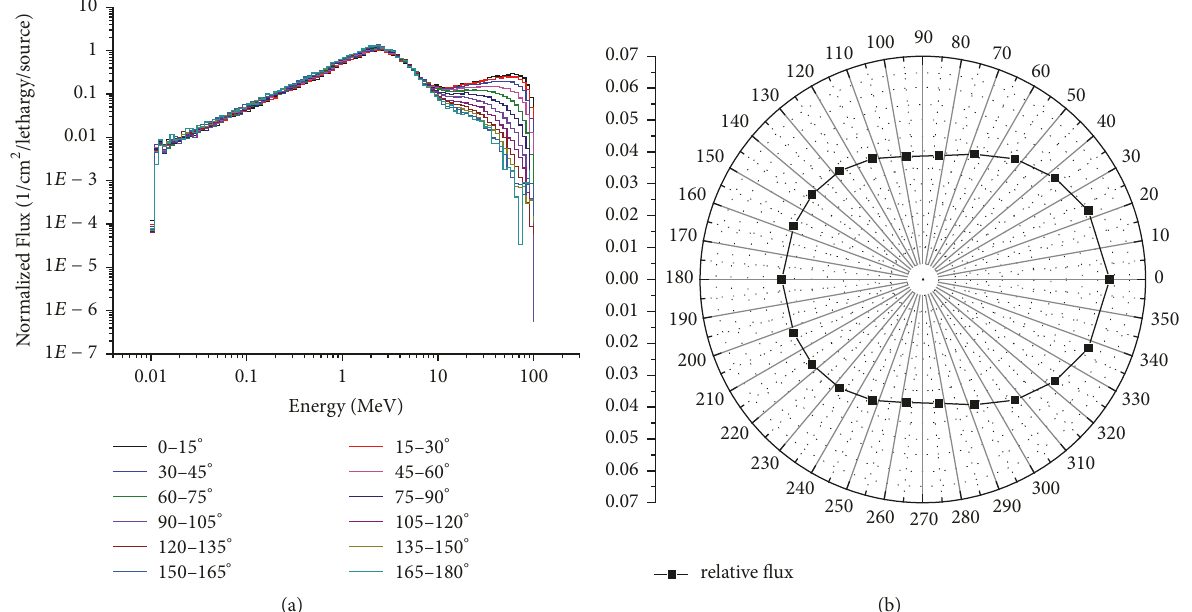
Figure 2: Spallation neutron spectra (a) and relative angular flux distribution